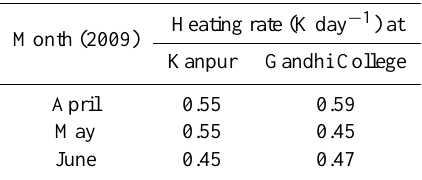
Table 3. Mean heating rate values (Kday − 1 ) at different stations over IGB region during